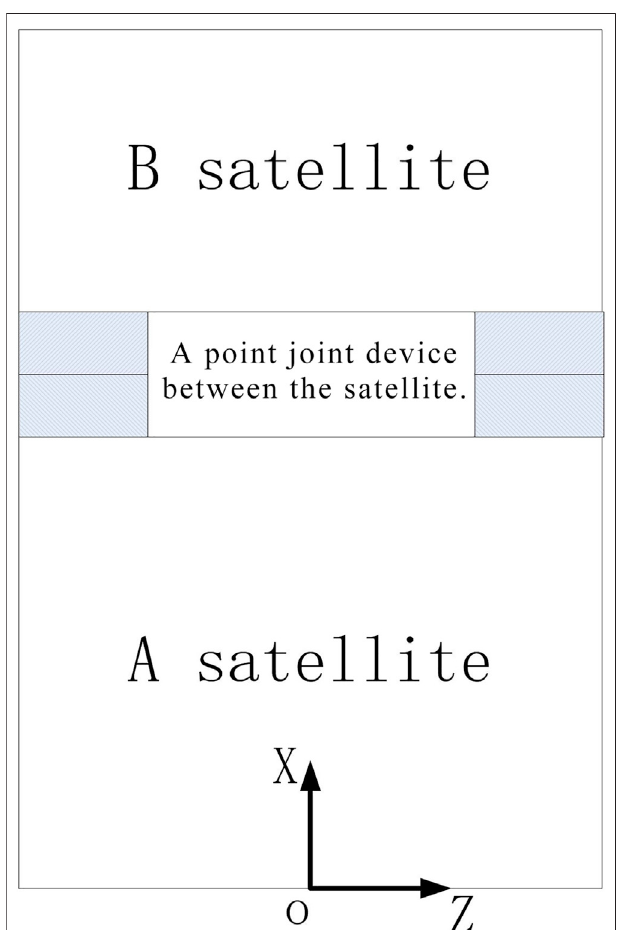
FIGURE 1 | The launch con fi guration of the self-tandem dual